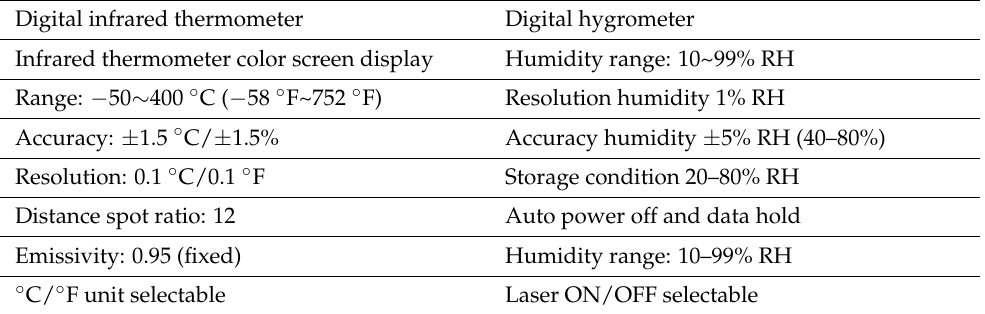
Table 1. Specifications of the sensors and data loggers.